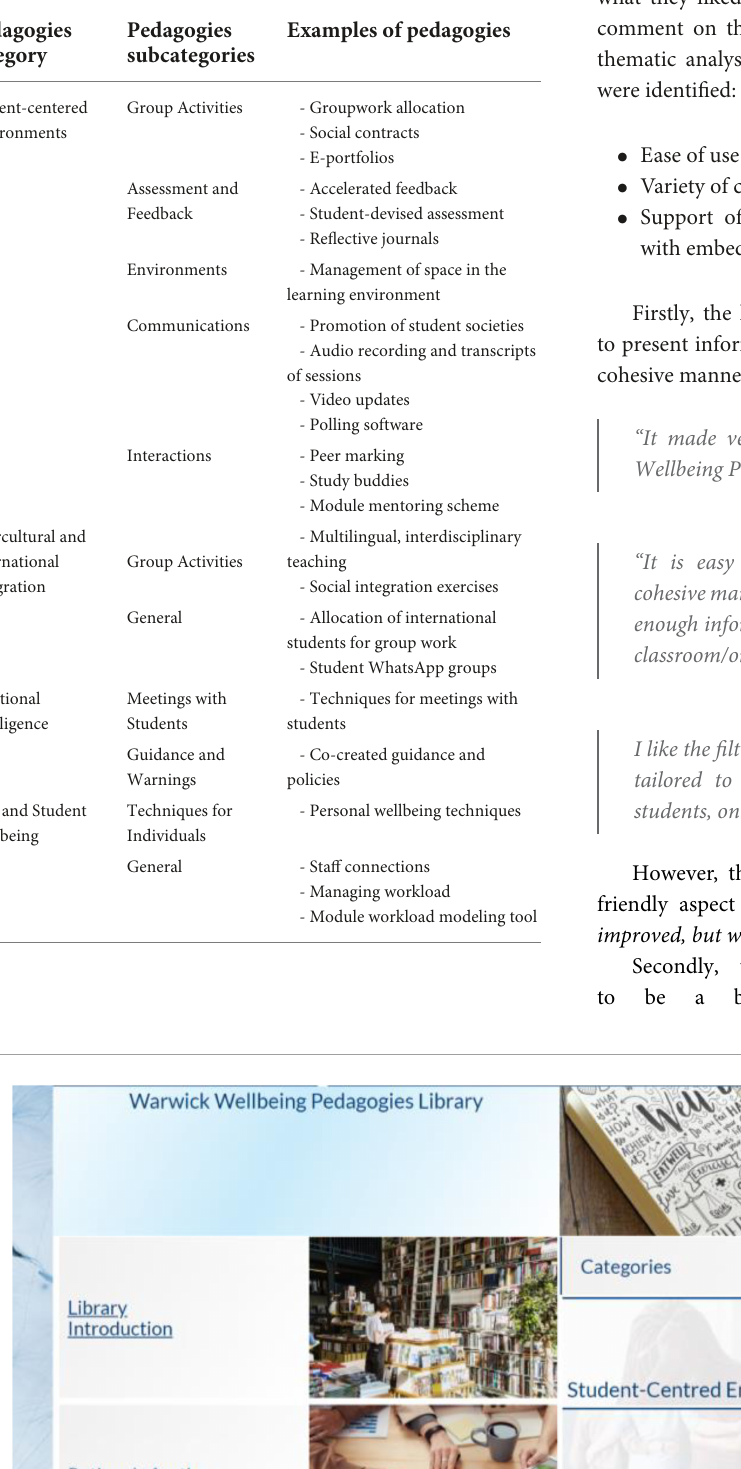
TABLE 5 University of Warwick digital repository wellbeing pedagogy